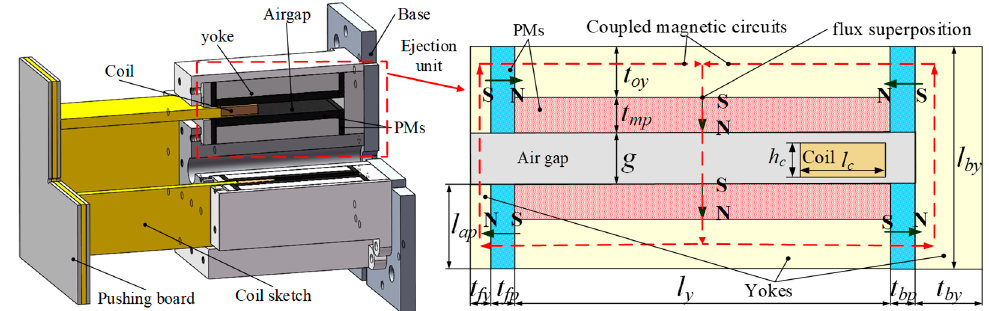
Figure 4. Configuration of the electromagnetic launcher.